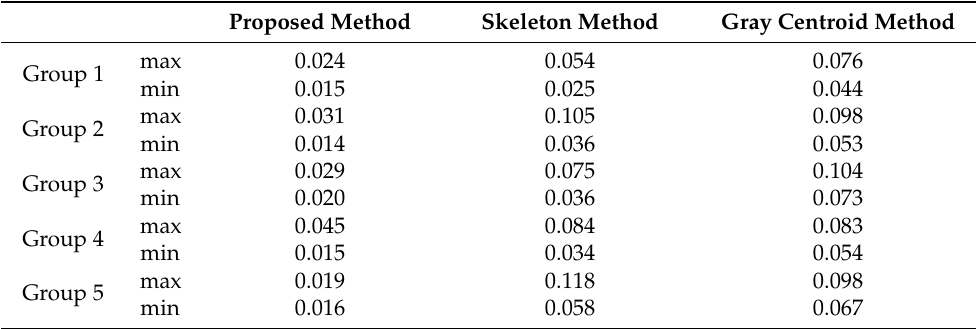
Table 1. Comparison between different methods and the standard method for extracting light stripe center (unit: